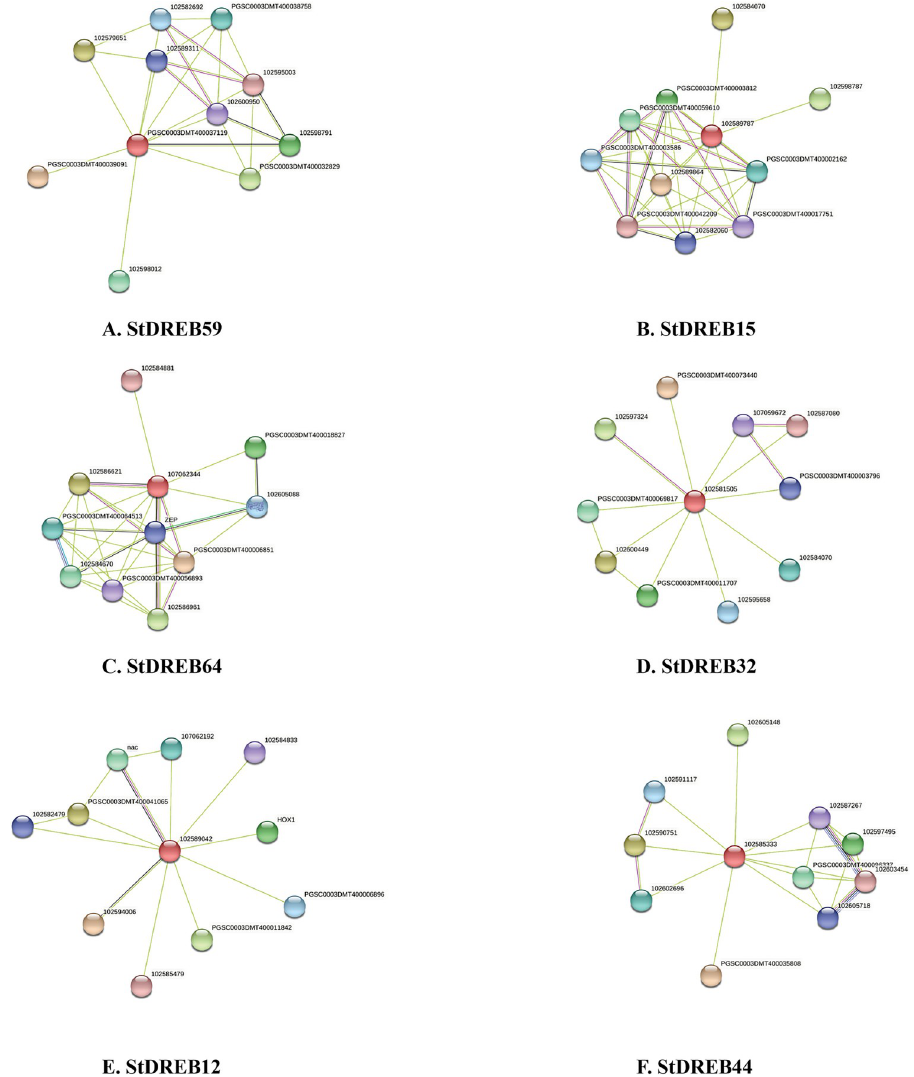
Fig 11. Protein-protein interaction networks of (A) StDREB59, (B) StDREB15, (C) StDREB64, (D) StDREB32, (E) StDREB12, and (F) StDREB44 detected through STRING tool. The red node indicated six query proteins from A1-A6 subgroups and other nodes represented their predicted functional partners. The light green, magenta, black, green, aqua, blue, and light sky blue lines represented protein-protein associations predicted by text-mining, experimental determination, co-expression, gene neighborhood, gene co-occurrence, curated databases, and protein homology respectively.